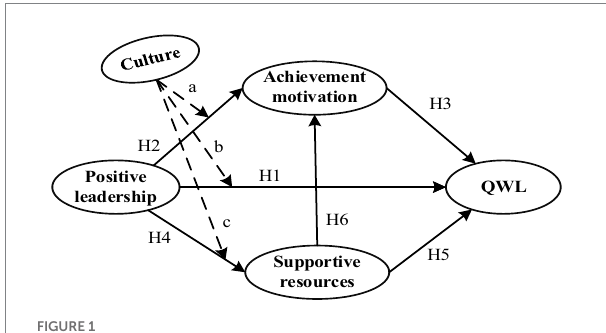
FIGURE 1 Research model diagram of promoting the QWL of family